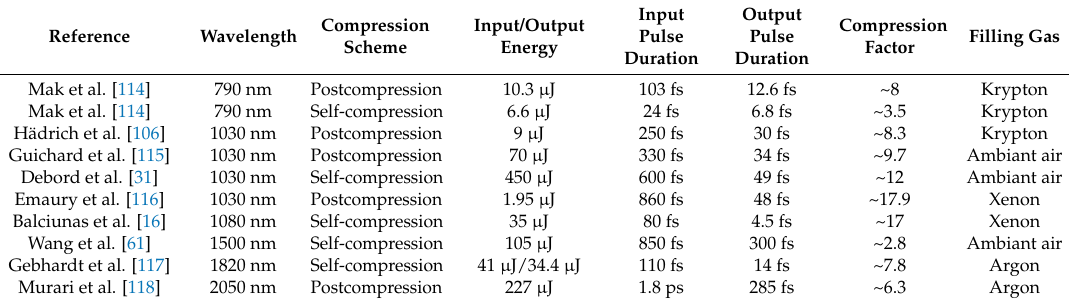
Table 1. Representative pulse compression performances in HCPCF